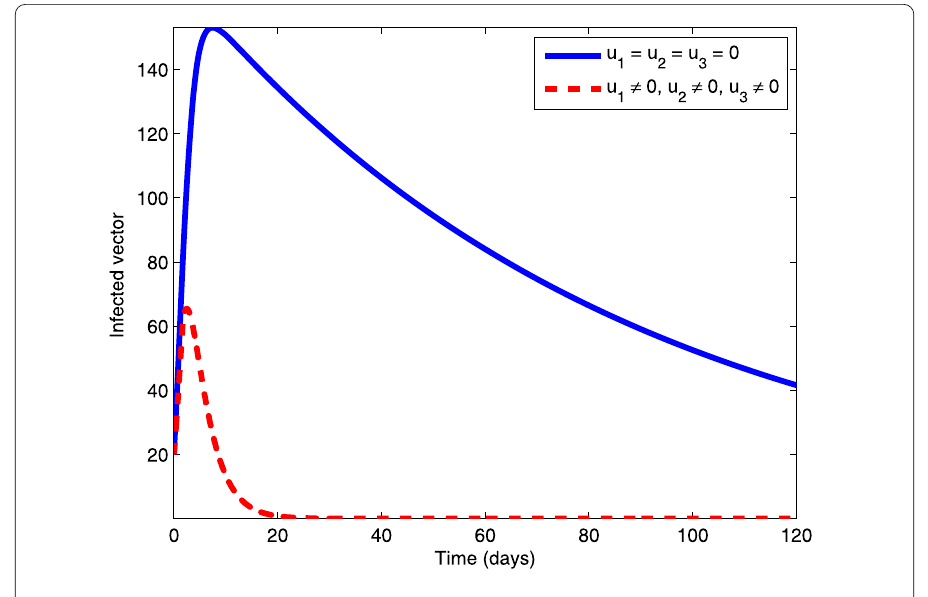
Figure 13 Infected Vectors with and without control.